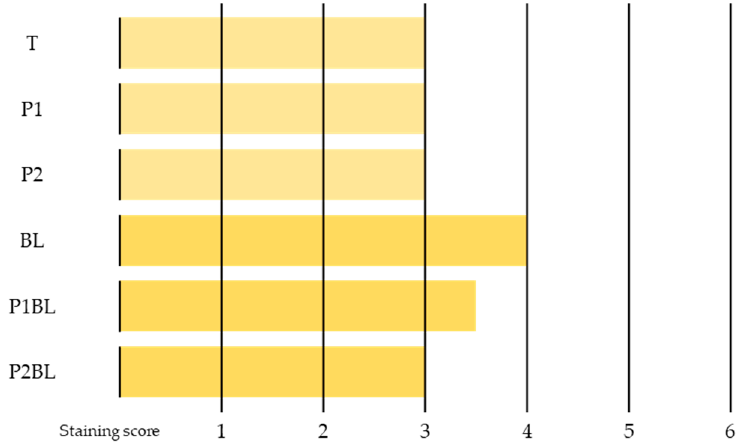
Figure 5. Scoring of the Nrf2 immunostaining by microscopical examination on D6, on unexposed